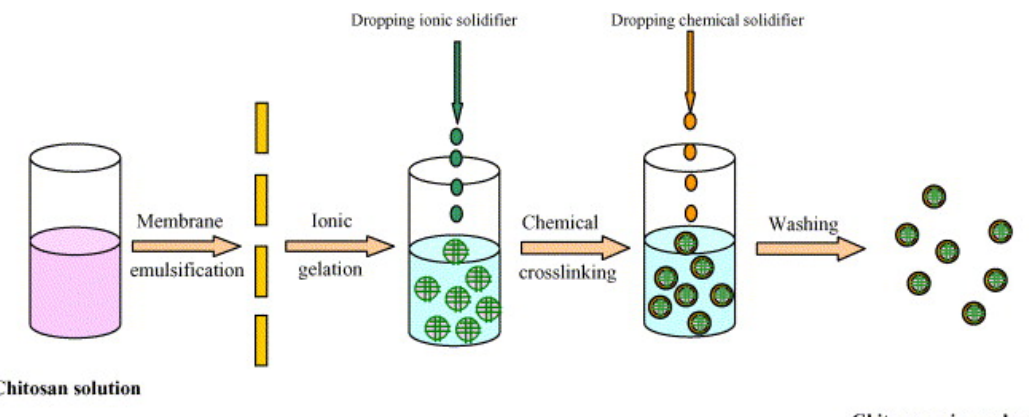
Figure 4. Diagram showing the synthesis of insulin-loaded CHC microspheres via ionic crosslinking to produce microgels in conjunction with chemical crosslinking. Adapted with permission from [46]; Published by Elsevier, 2006.